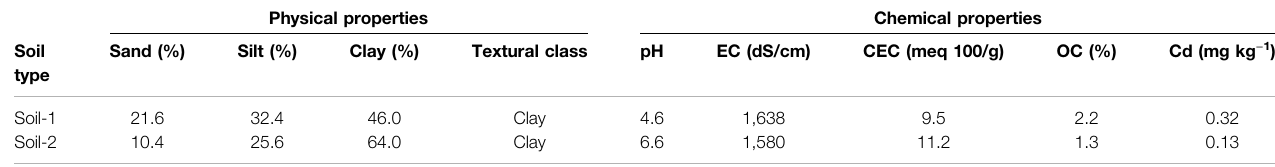
TABLE 1 | Basic physico-chemical characteristics of soil in this